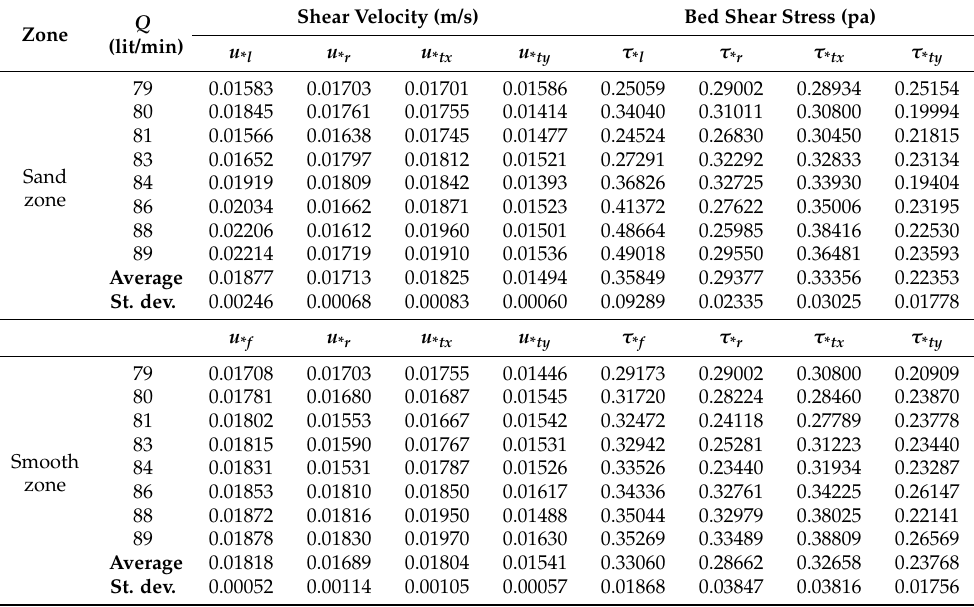
Table 3. Estimated shear velocity and bed shear stress by different indirect